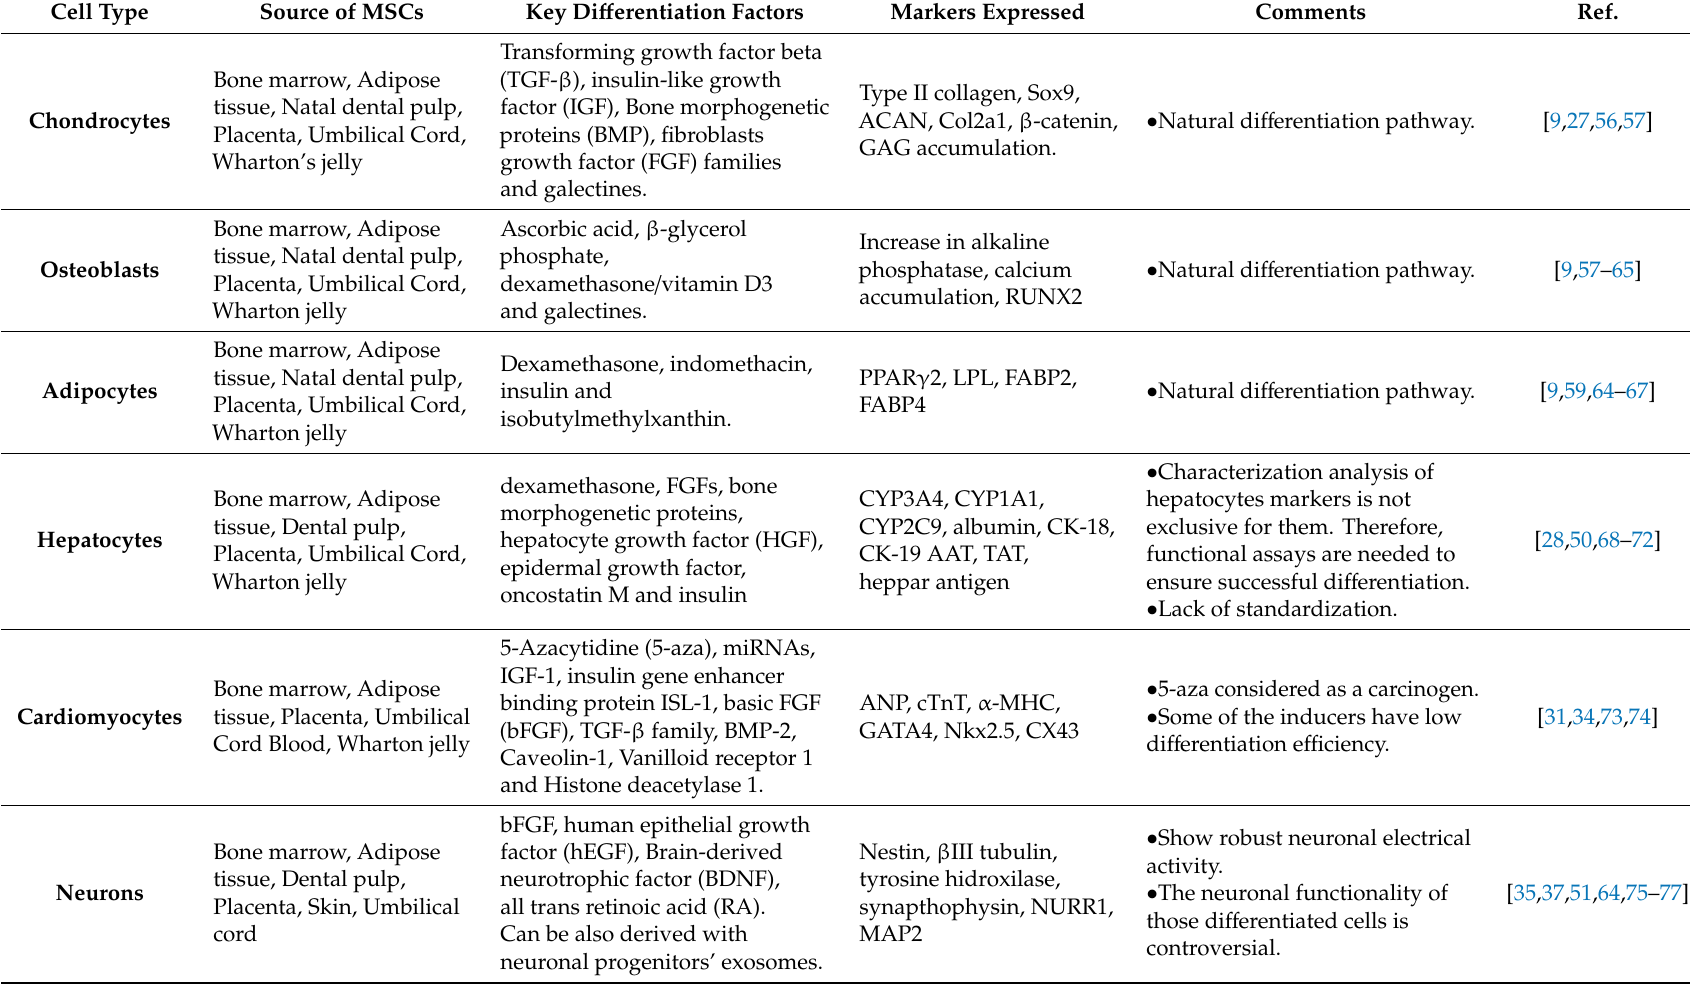
Table 1. Di ff erentiation lineages of MSCs induced by